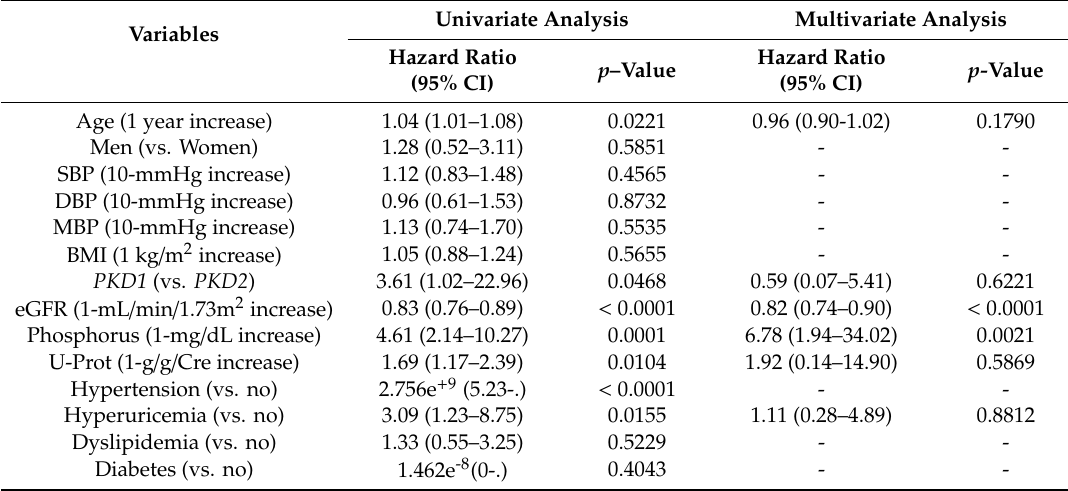
Table 2. Univariate and multivariate Cox analysis of risk factors associated with renal replacement therapy (n =